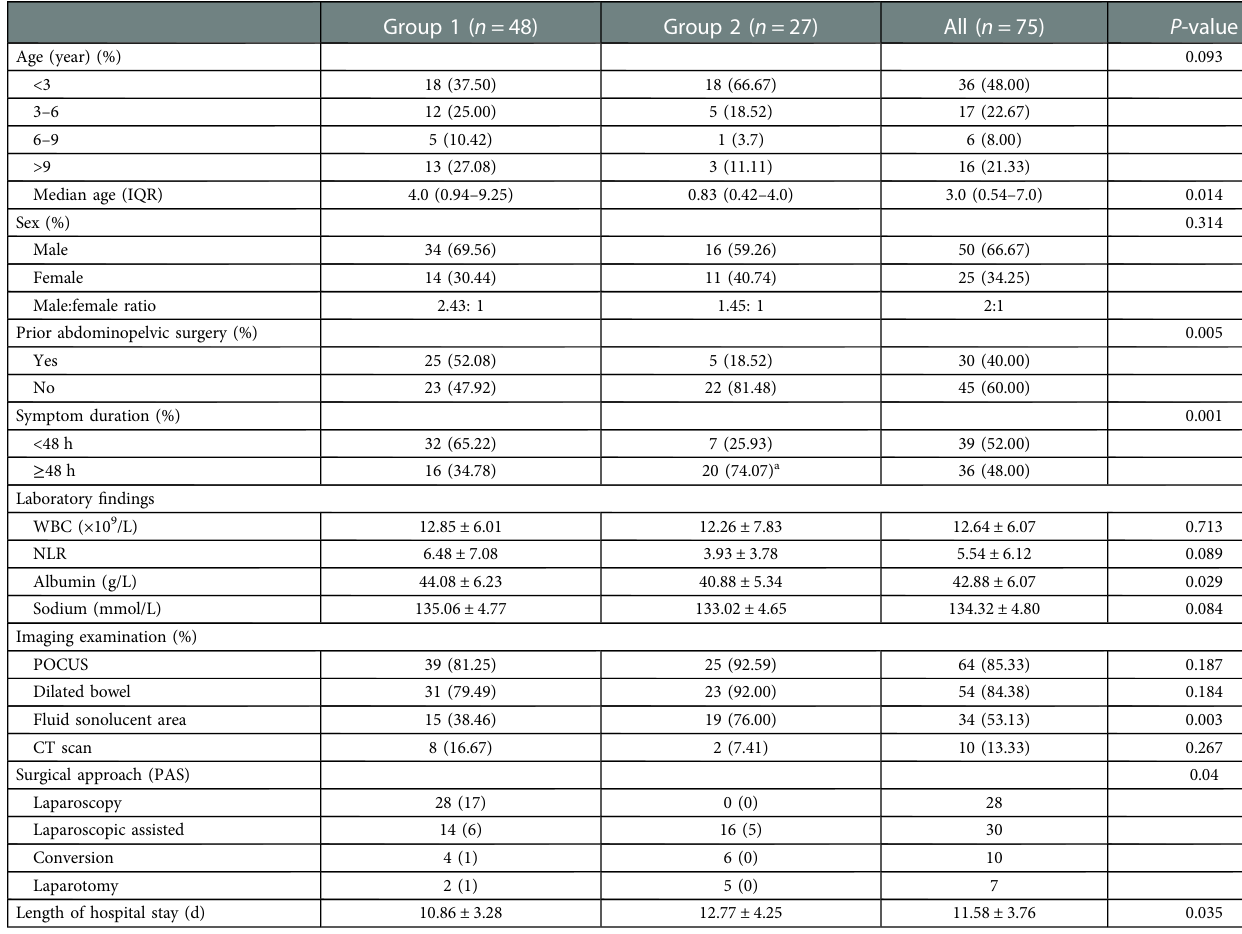
TABLE 1 Detailed data in the present case